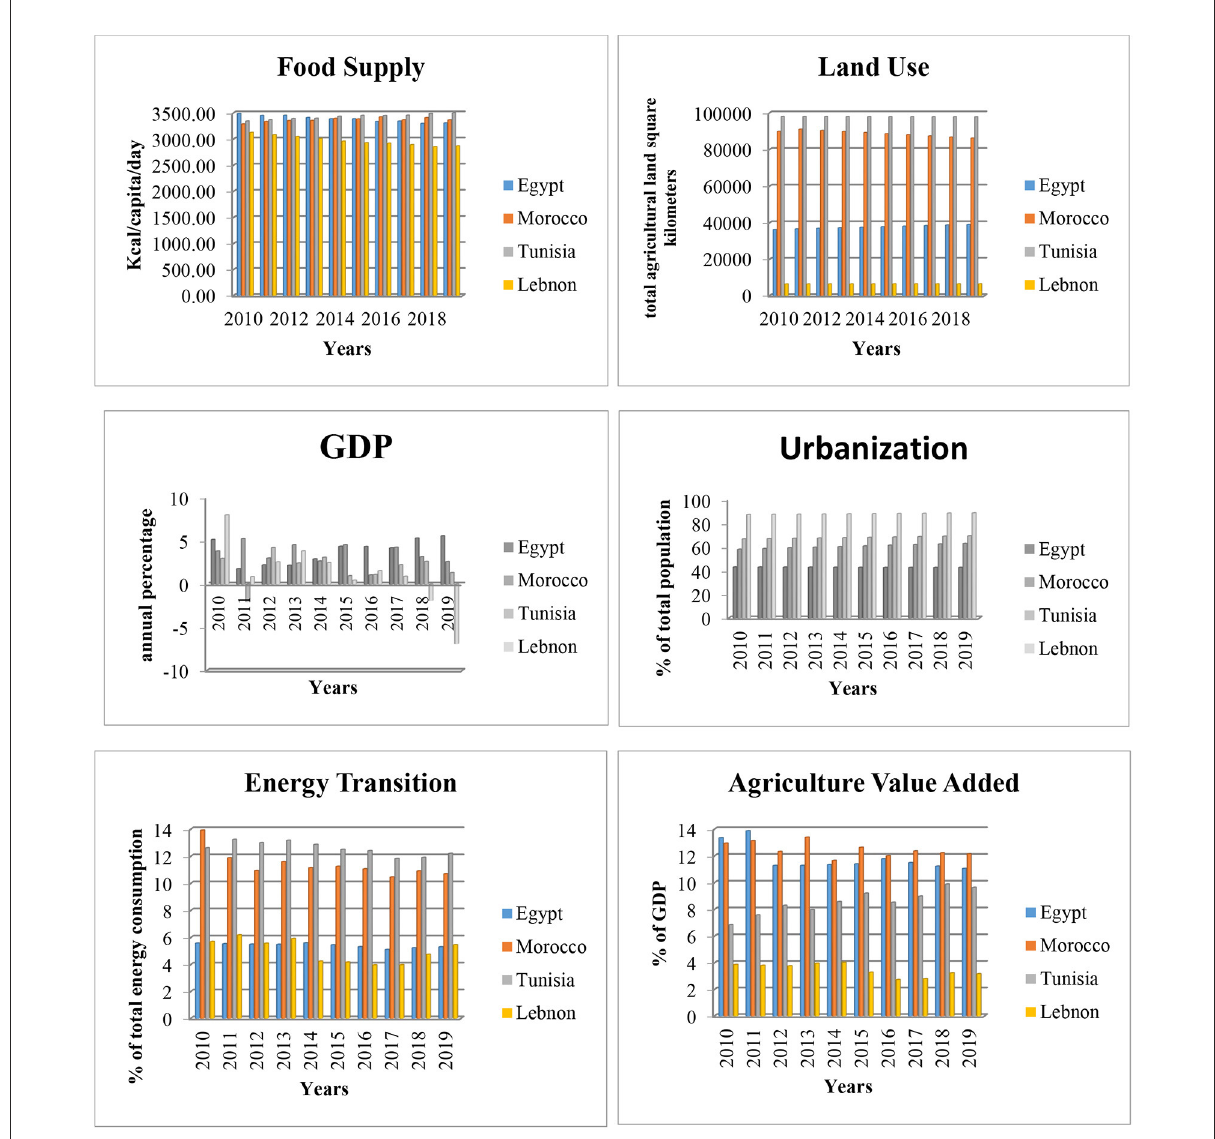
FIGURE1 3D graphs showing land-use, food supply, and urbanization, GDP, AVA, and energy transition.